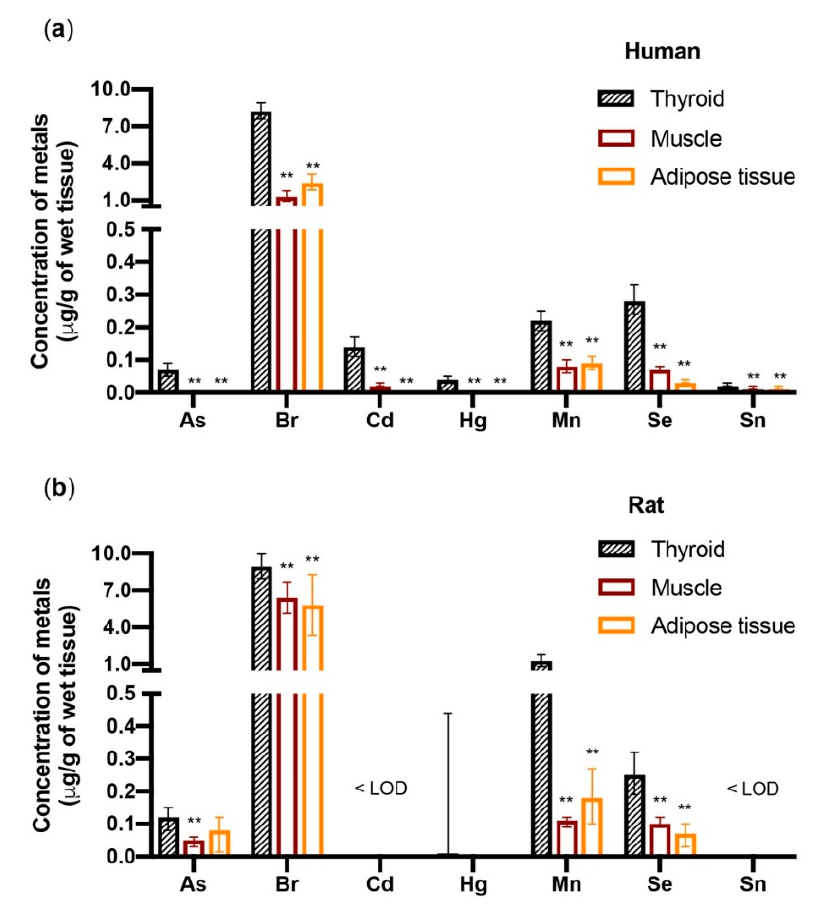
Figure 2. Metals accumulate in the thyroid more than in muscle and fat. The bars indicate the geometric mean and the 95% confidence interval of the metals ( µ g/g of wet tissue) in the tissues of ( a ) 77 euthyroid subjects (F = 70.1%) and ( b ) 8 female Wistar rats. Human specimens were collected from the thyroid, the sternothyroid muscle, and the neck subcutaneous fat. Rat specimens were collected from the thyroid, the hindlimb muscle, and the visceral abdominal fat. Only metals that accumulated in the human thyroid significantly (** p < 0.01) more than in muscle and fat are shown. In rats, but not in humans, Cu and Zn also significantly accumulated in the thyroid more than in the other two tissues (not shown, see ref. [41]). < LOD = below the limit of detection. Represented data are derived from ref.